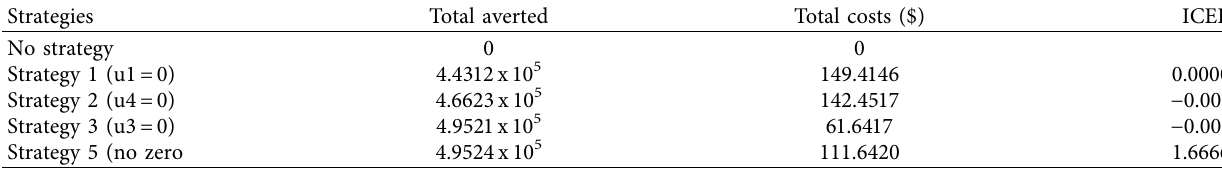
Table 3: Rank of strategies based on the number of the infection averted.